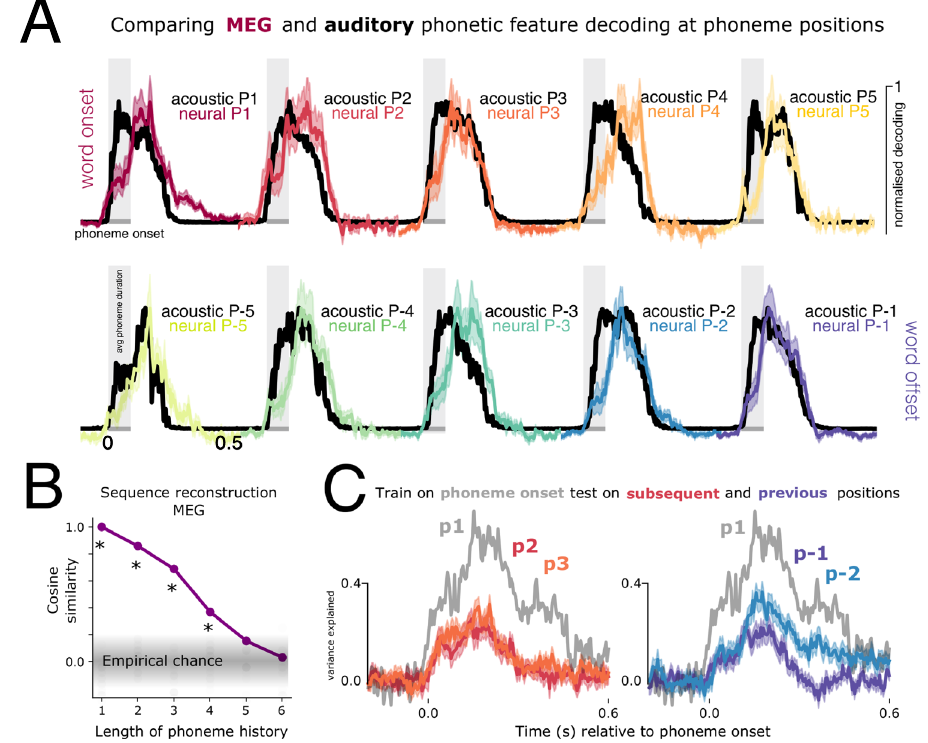
Fig.2|Decodingasafunctionofphonemeposition.A Timecoursesofdecoding phoneme-level features from the mel spectrogram (black) and MEG sensors (coloured), time-locked to phoneme onset. Performance is averaged over the 14 phonetic feature dimensions. Shading in the neural data corresponds to the stan- darderrorofthemeanacrossthe21participants.Resultsareplottedseparatelyfor 10 different phoneme positions, where P1:P5 indicates distance from word onset (red colour scale) and P-1:P-5 distance from word offset (purple colour scale). E.g. P-1isthe last phoneme ofthe word, P-2isthe second to last phoneme of the word. Y -axisshowsthebetacoef fi cientsnormalisedbetween0 – 1.Allplotssharethesame y-axis scale. B Result of simulating and reconstructing phoneme sequences from the MEG model coef fi cients. x -axis represents how many previous phonemes can bereconstructed; y -axisrepresentsthecosinesimilaritybetweenthetruephoneme